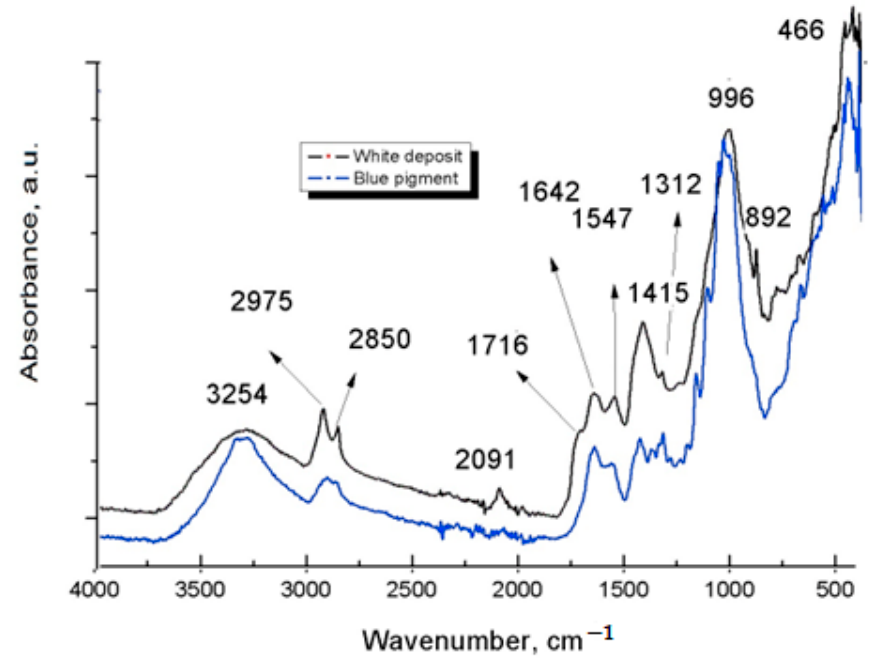
Figure 9. FTIR spectra of blue pigments and white deposits.